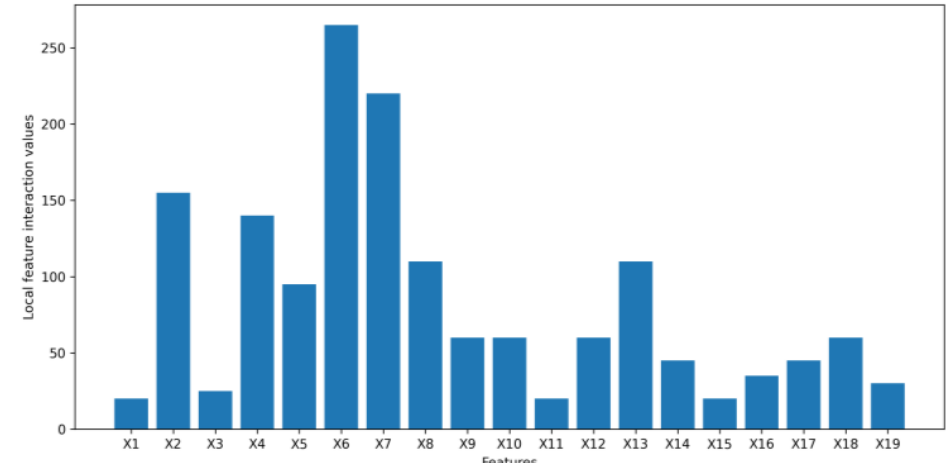
Figure 16. Global feature interaction values for dataset 1.